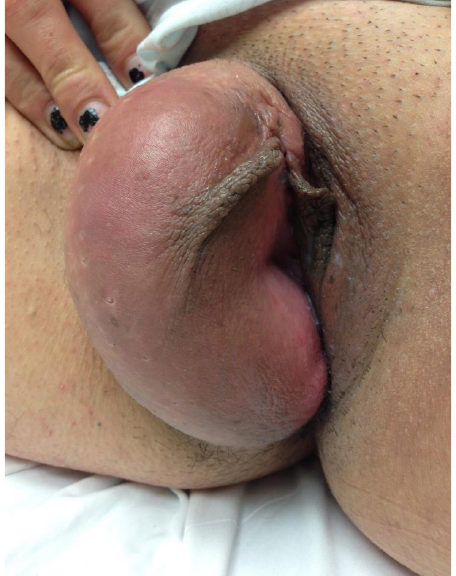
Figure. Swelling of the right labia